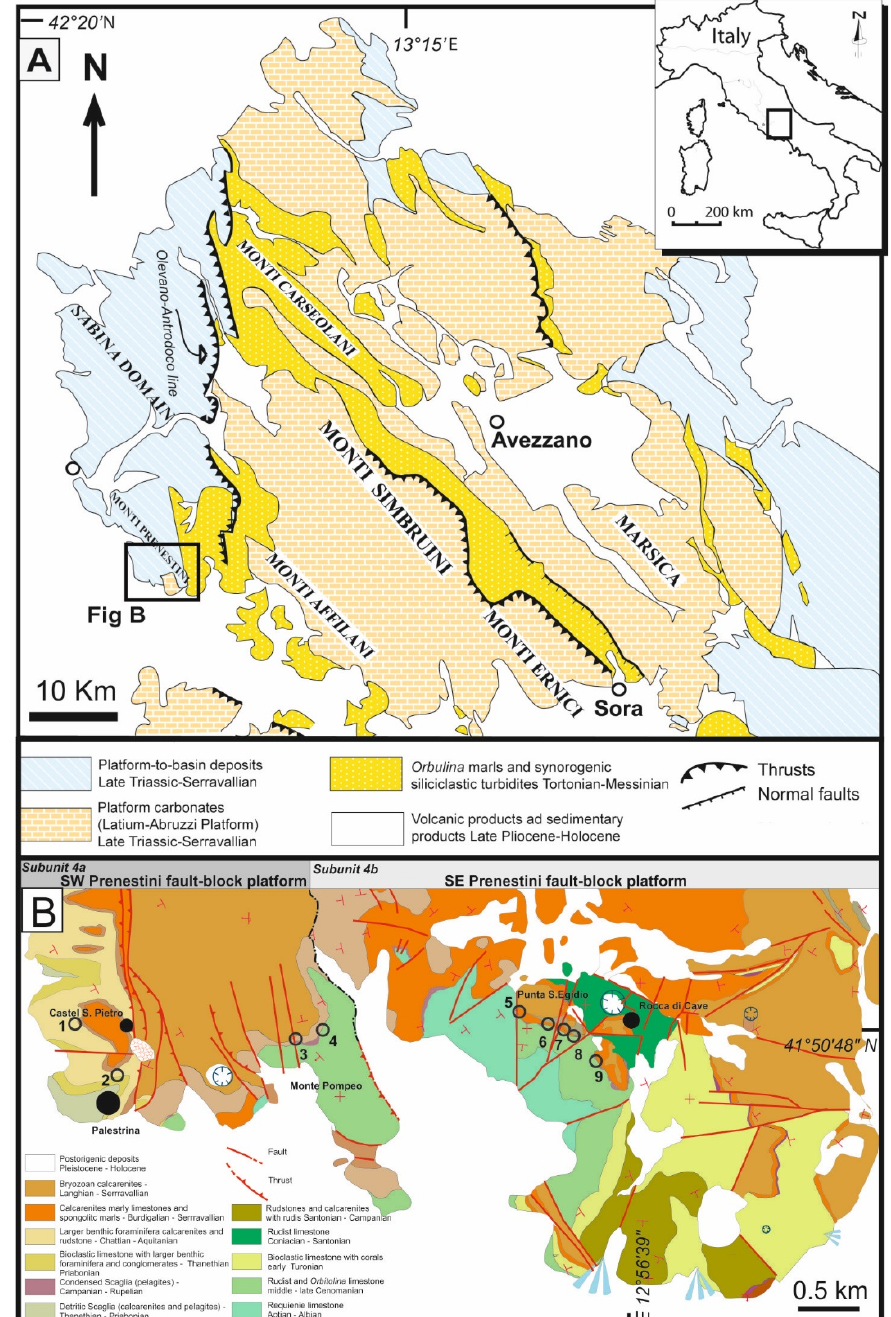
Figure 1. Geological map of the investigated area. ( A ) Basinal and carbonate platform domain of central Apennines modified from [34]; ( B ) geological map of Southern Prenestini and location of investigated outcrops modified from [35].